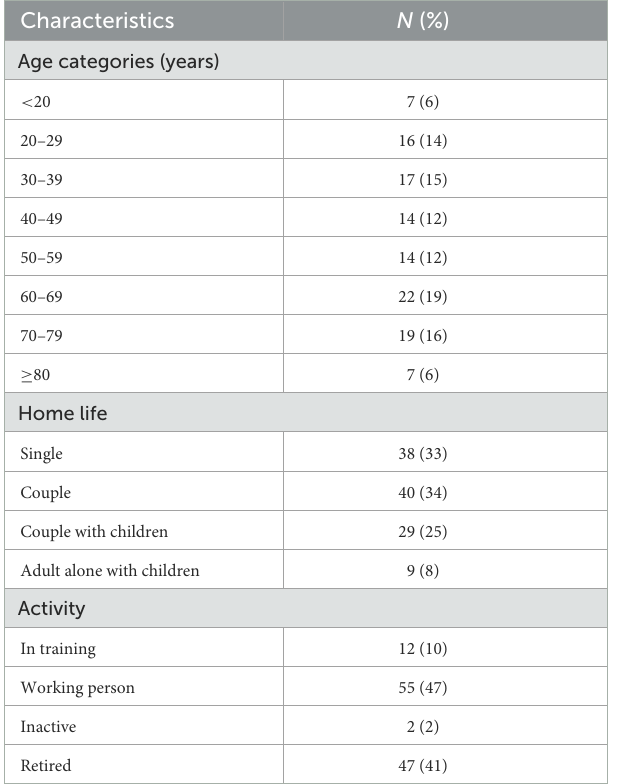
TABLE 2 Demographic characteristics of the